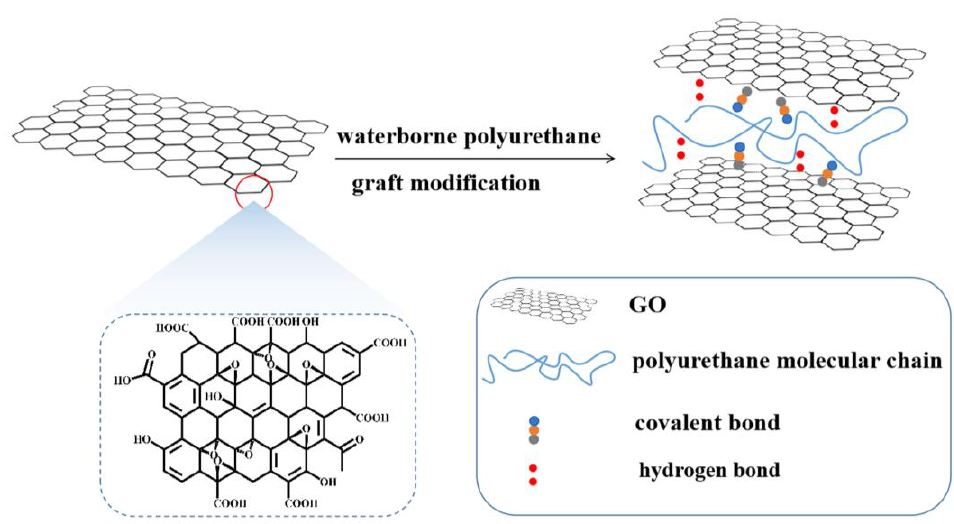
Figure 1. GO modified WPU schematic diagram.